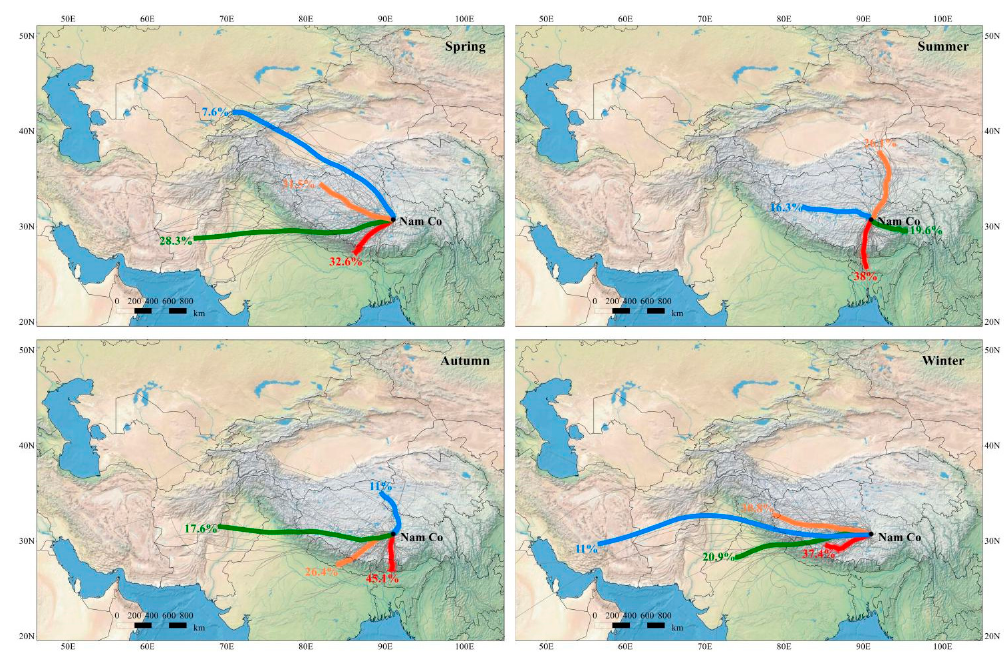
Figure 8. Cluster-mean 5-day backward air-mass trajectories calculated by the HYSPLIT model, including the percentages of each cluster trajectory during spring, summer, autumn, and winter.